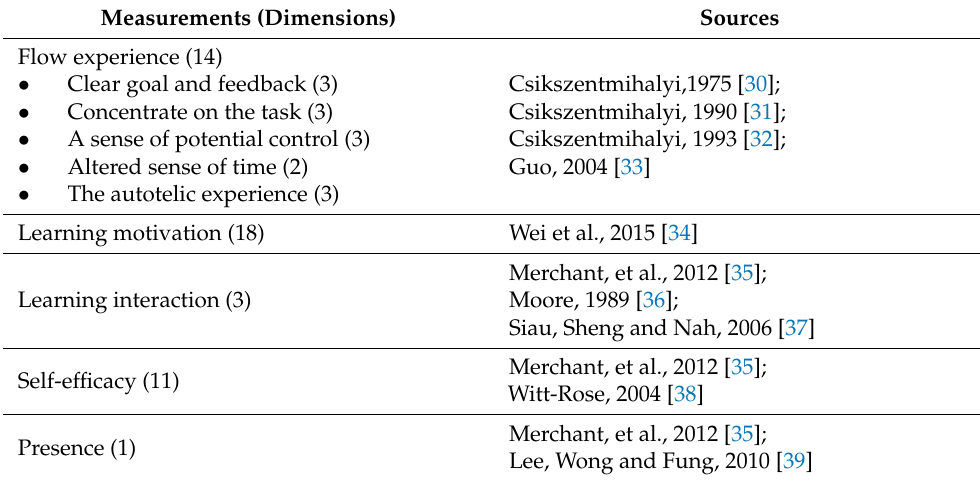
Table 4. Measurement sources and numbers of items.